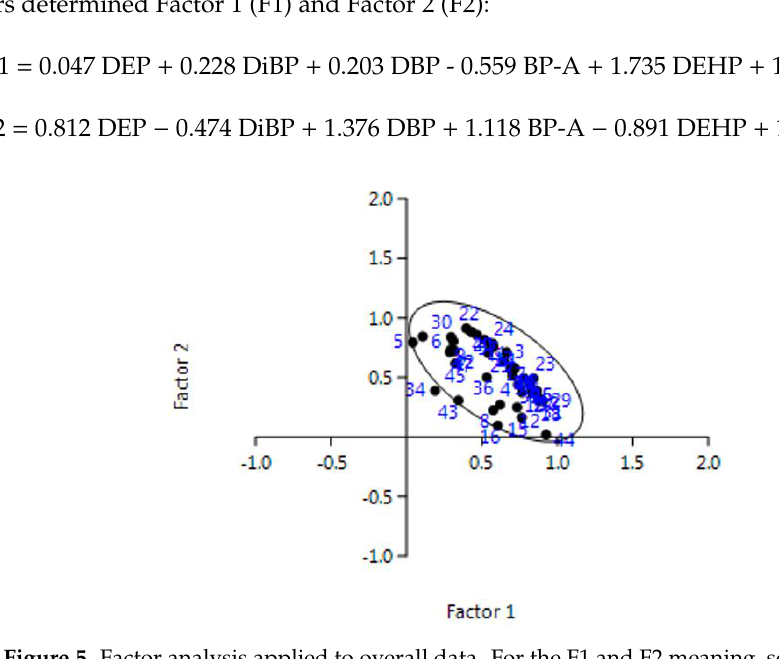
Figure 4. Dendrogram showing the similarities among the samples investigated in this study.